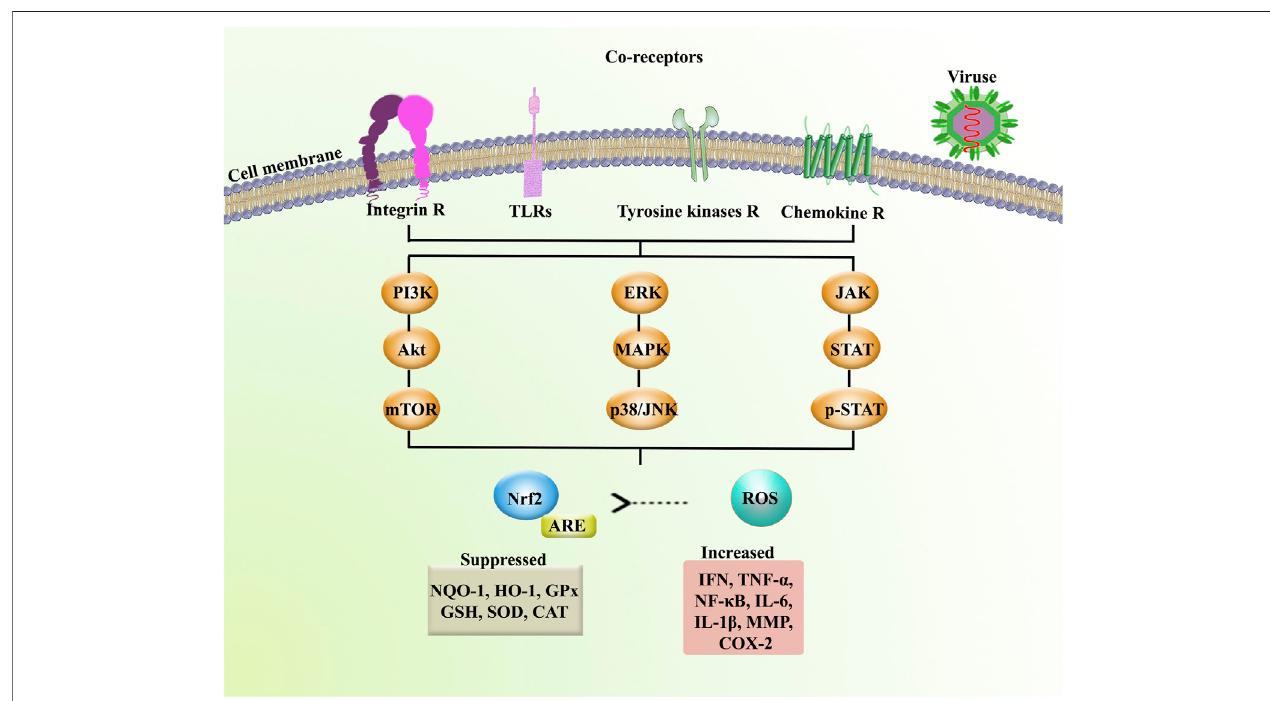
FIGURE 4 | Receptors and signaling mediators involved in neuronal signs of emerging infectious diseases. Akt: protein kinase B, ARE: antioxidant response element, CAT: catalase, Chemokine R: chemokine receptor, COX-2: cyclooxygenase-2, ERK: extracellular signal-regulated kinase, GPx: glutathione peroxidase, GSH: glutathione, HO-1: heme oxygenase-1, IFN: interferon, IL: interleukin, Integrin R: integrin receptor, JAK: Janus kinase, mTOR: mammalian target of rapamycin, MMP: matrix metalloproteinase, NF- κ B: nuclear factor-kappa B, NQO-1: NAD(P)H Quinone Dehydrogenase 1, Nrf2: nuclear factor erythroid 2-related factor 2, p38: p38 mitogen-activated protein kinase, p-STAT: phospho-signal transducer and activator of transcription, SOD: superoxide dismutase, STAT: signal transducer and activator of transcription, TLRs: toll-like receptors, TNF- α : tumor necrosis factor- α , and Tyrosine kinase R: tyrosine kinase receptor.